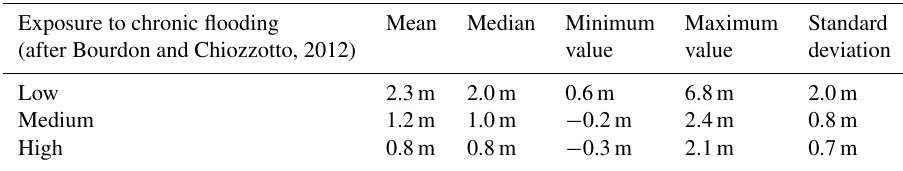
Figure 5. Tide gauge data. (a) Time series of raw data (black: raw cleaned data; red: data removed from the analysis and corresponding to the cyclones, identified with blue lines). (b) Distribution of total water level daily maxima, after the water level data post-processing described in Sect. 3.3 (cyclone removed, year and day filtering, detrended sea-level rise). Table 4. Altitude of coastal locations according to the lidar altitude dataset (reference: regional geodetic reference, IGN88). See Fig. 7 for the precise location of each